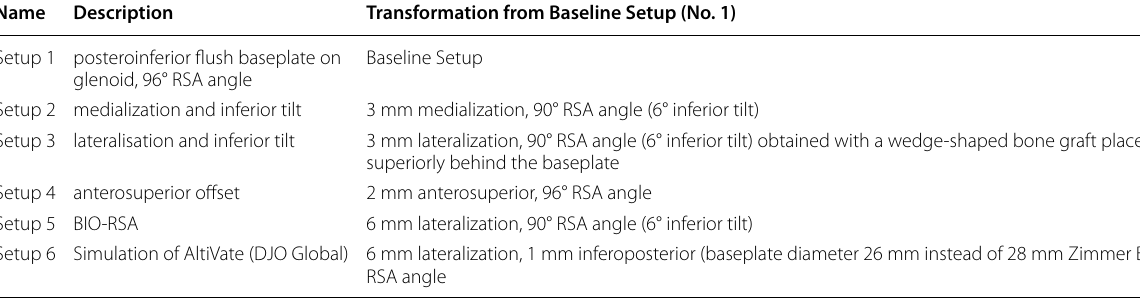
Table 1 Description of the different glenoid setups that were